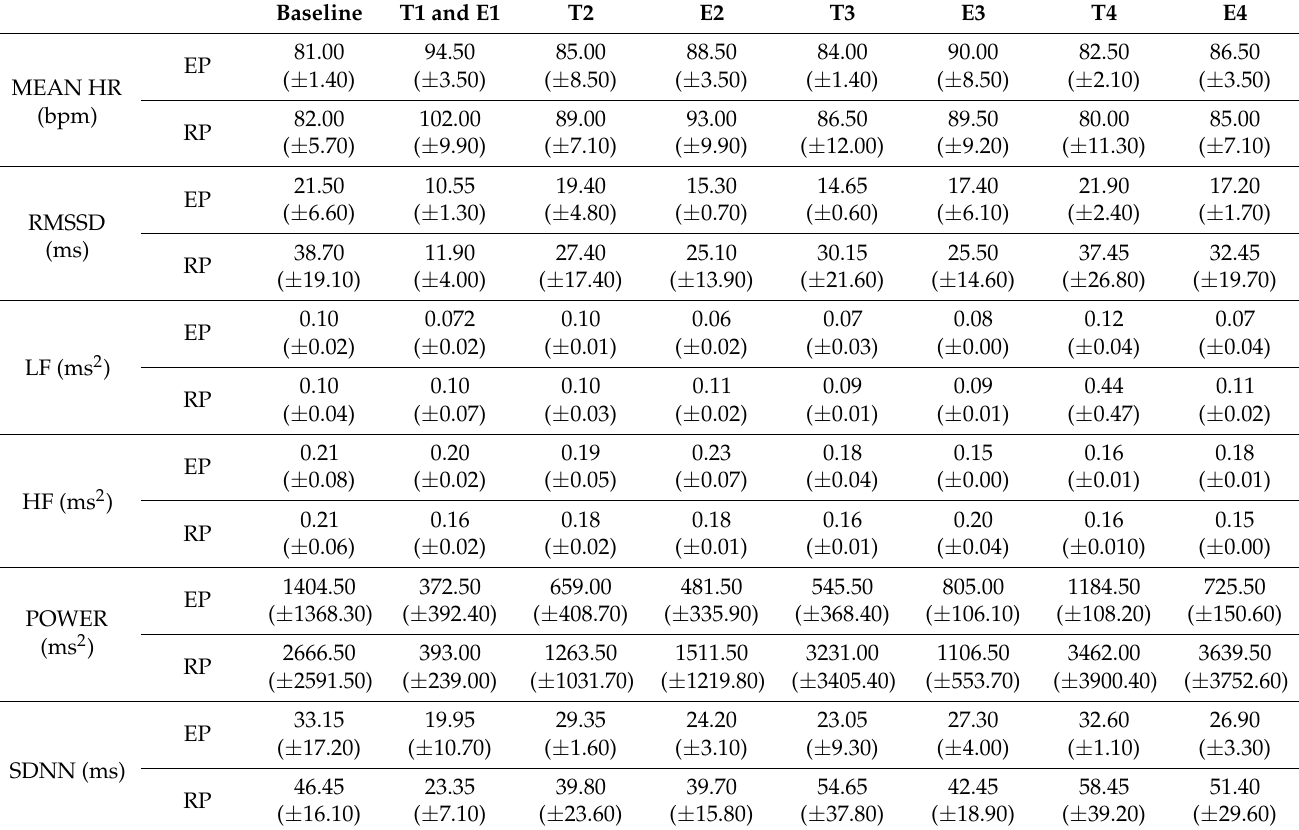
Table 2. The results of the HRV in baseline and emergency maneuvers for the two EP and the two